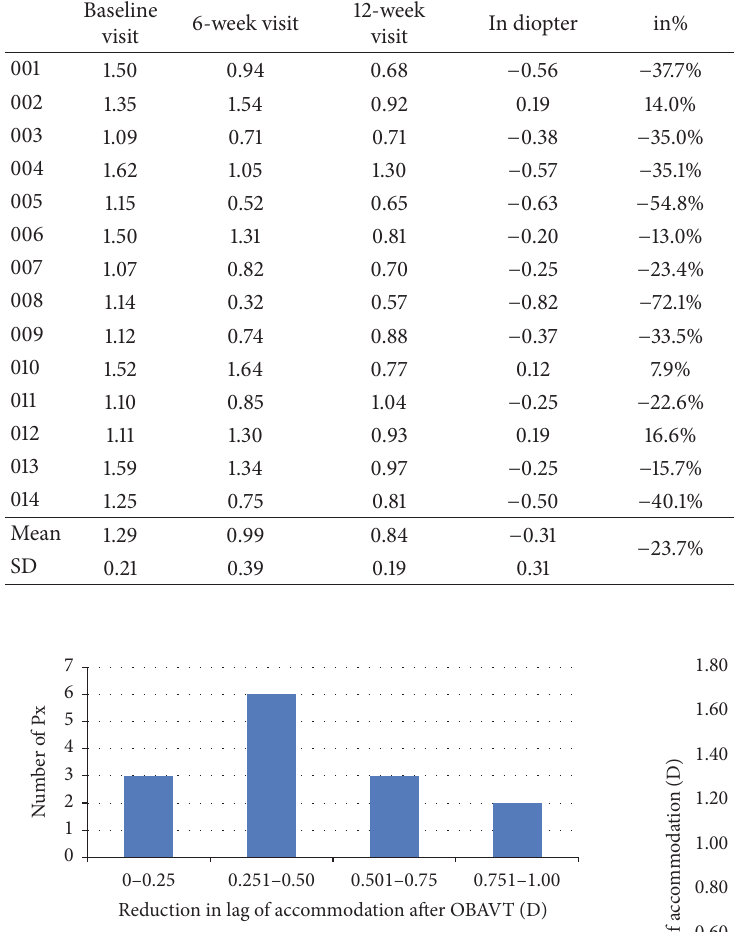
Figure 1: Distribution of reduction in lag of accommodation after vision therapy.